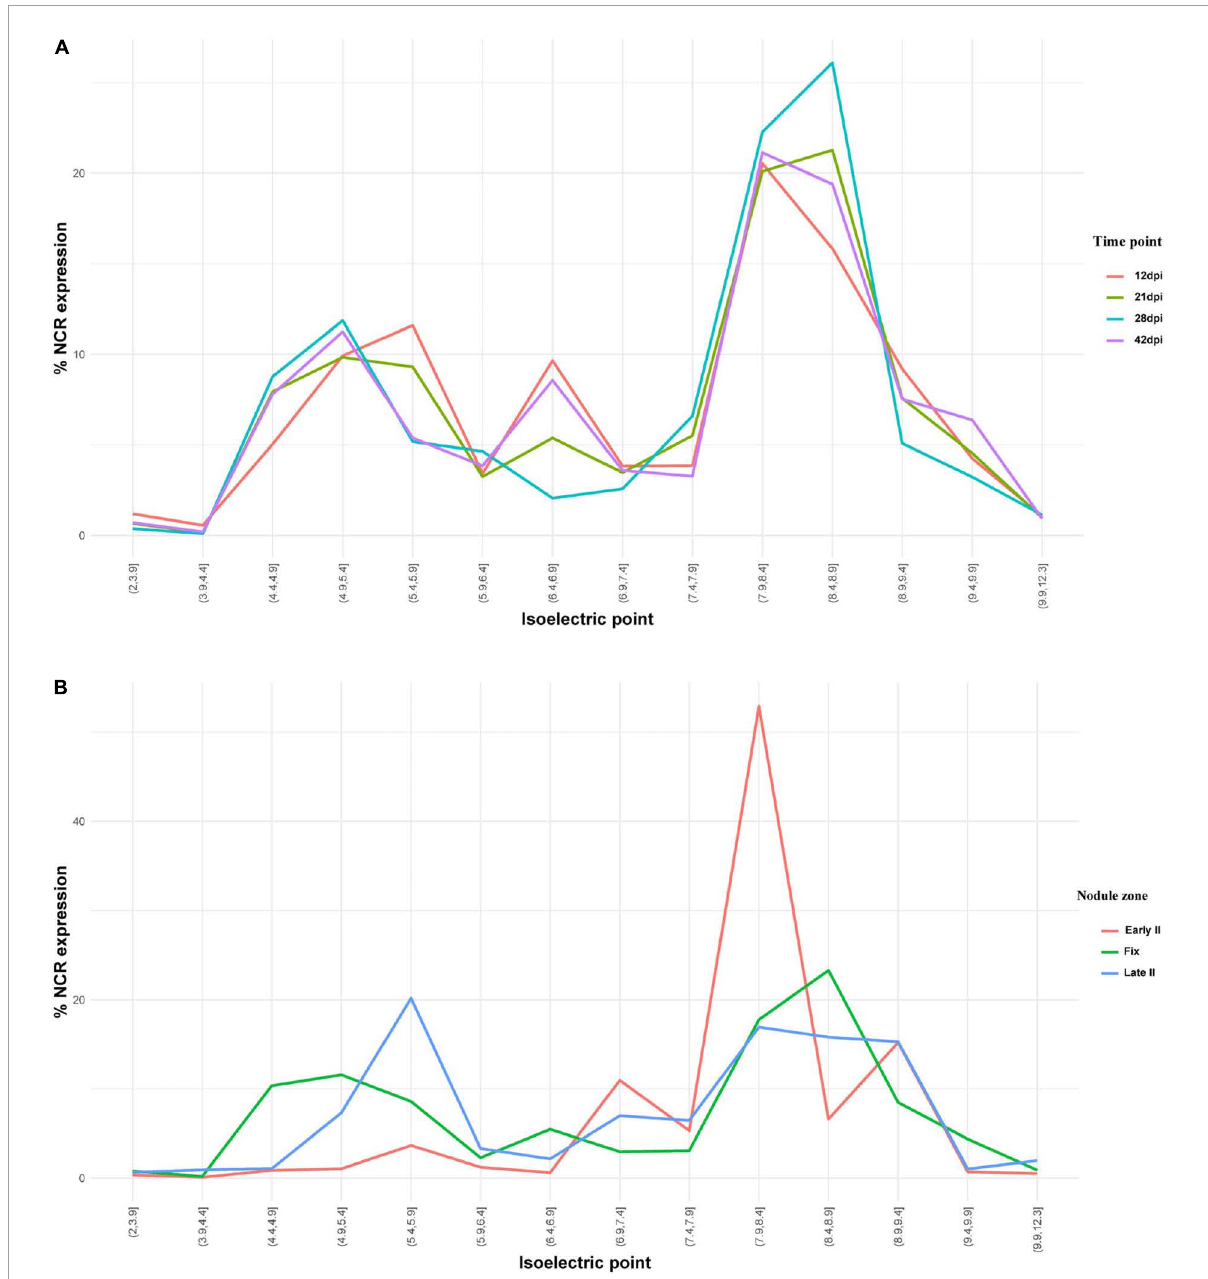
FIGURE7 (A) Isoelectric point profiles of NCR peptides and the relative expression of NCRs with different Pl across days after inoculation (dpi). (B) Isoelectric point profiles of NCR peptides and the relative expression of NCRs with different Pl in different zones of P. sativum nodules. % NCR expression is % CPM normalized values of different isoelectric point categories to whole-nodule NCR